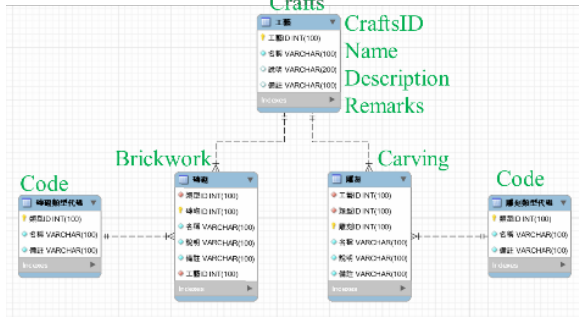
Figure 6. The Crafts part in the